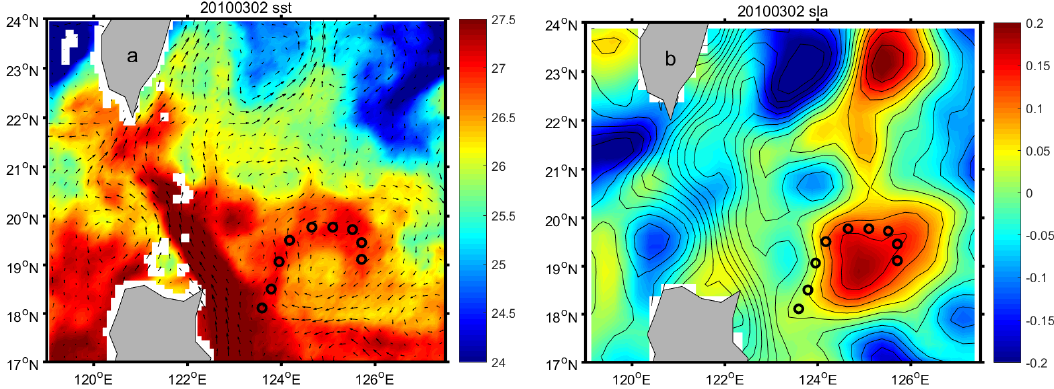
Figure 1. Snapshot of ( a ) SST (color, ◦ C) and geostrophic velocity (vectors); ( b ) sea level anomalies (SLA) (color, in m) and absolute dynamic topography (ADT) contours on 2 March 2010. Warm filaments are marked by small circles in the lower right quadrant of the frame accompanied by an anticyclonic eddy.